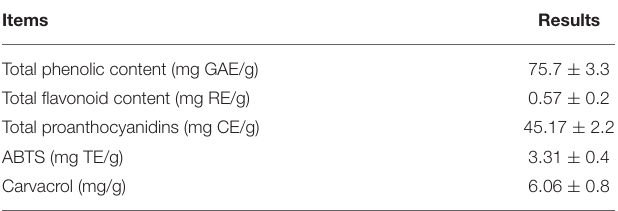
TABLE 1 | Phytochemical profile.